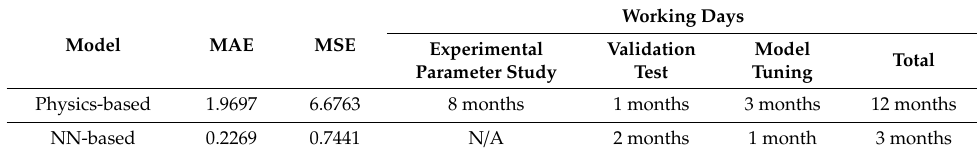
Table 6. Comparison of the forecasting models.